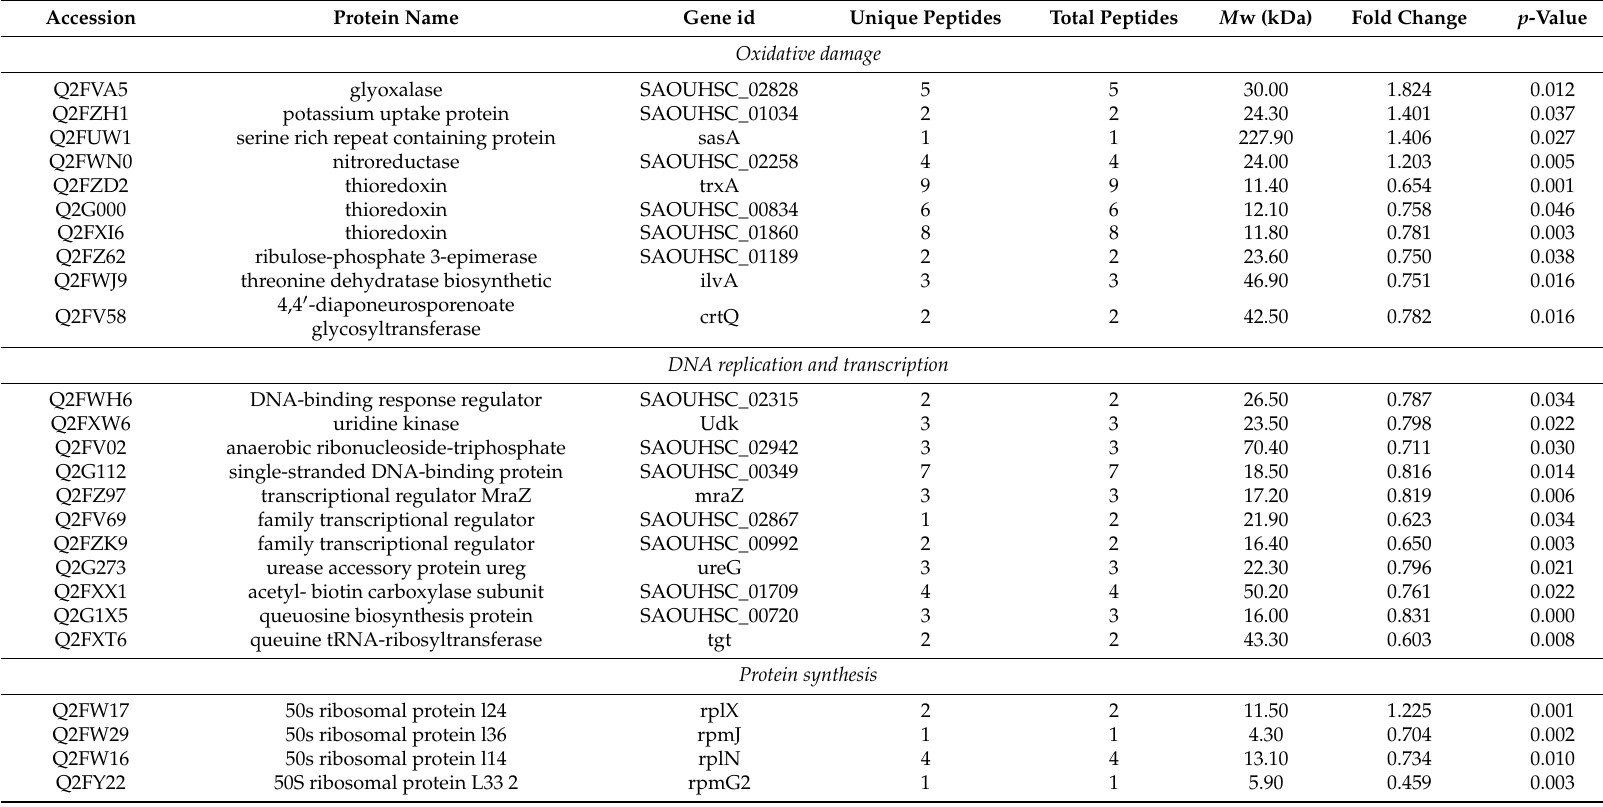
Table 1. Proteins that showed differential expression following treatment of Staphylococcus aureus with